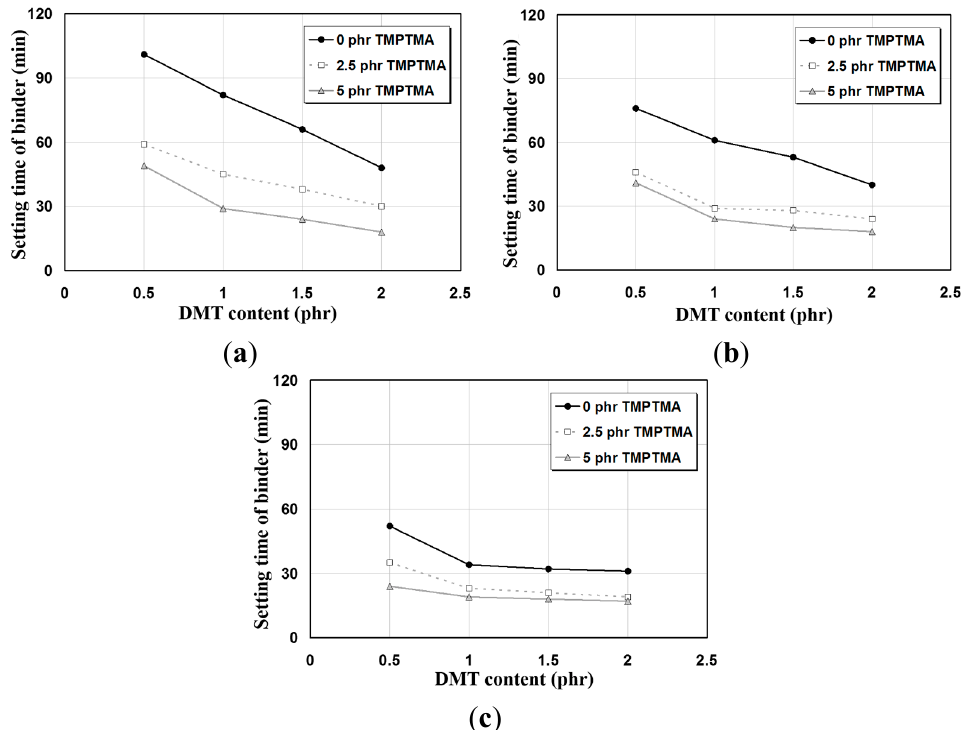
Figure 3. Effects of DMT and TMPTMA contents on the setting time of acrylic binder cured at different temperatures, ( a ) − 20 °C; ( b ) − 10 °C; and ( c ) 0 °C.